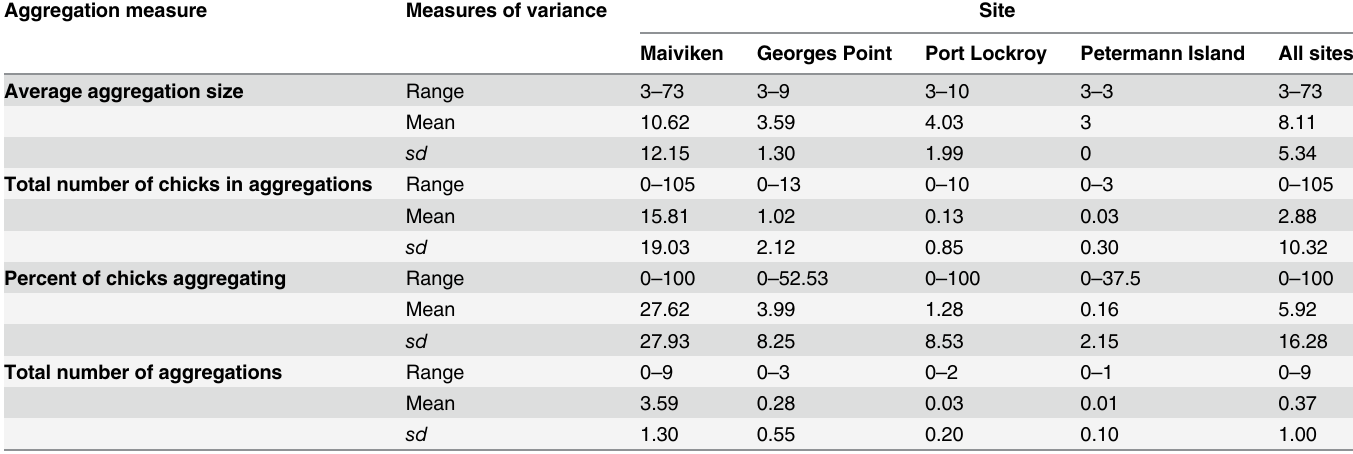
Table 2. Summary of measures of variance (range, mean, and standard deviation) in three aggregation characteristics (1) average aggregation size, 2) total number of chicks in aggregations, and 3) total number of aggregations at each of our four study sites and in total across all four sites: Maiviken, Georges Point, Port Lockroy, and Petermann